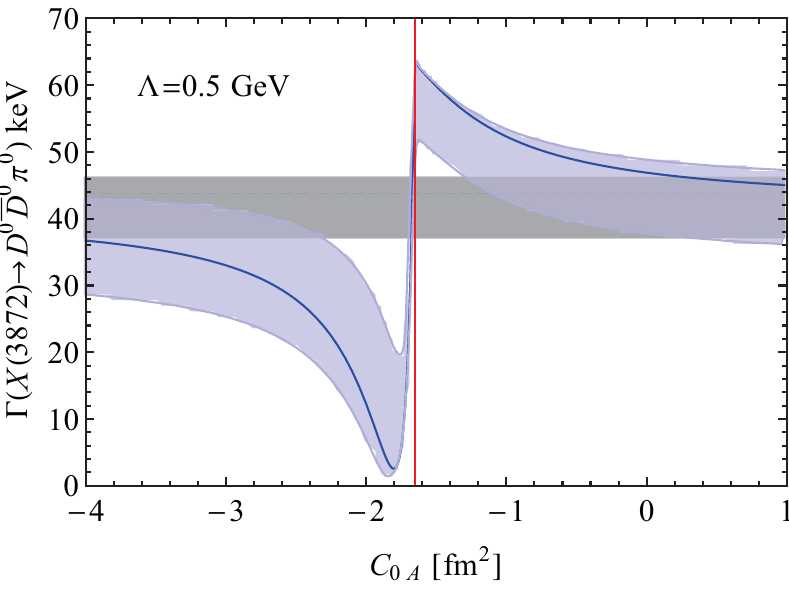
Figure 2. Dependence of the width of the X (3872) → D 0 ¯ D 0 π 0 decay on C 0 A for the cuto ff Λ = 0 . 5